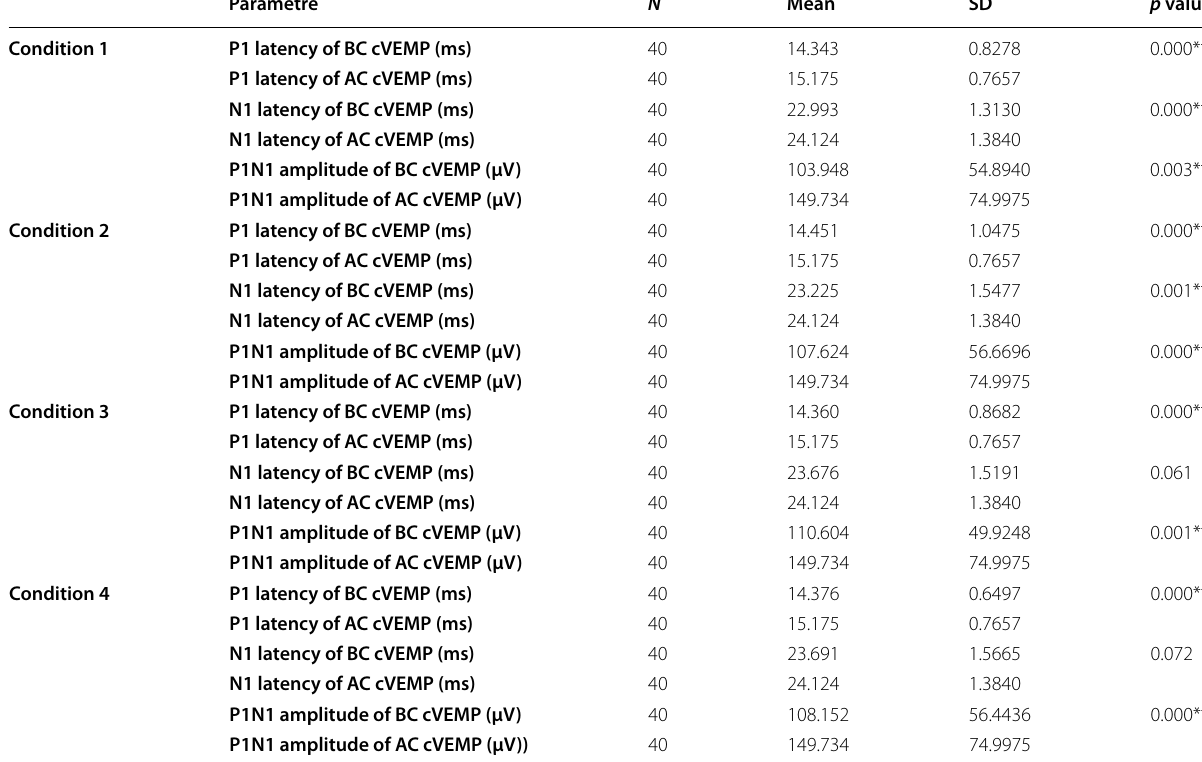
Table 4 Comparison of AC and BC cVEMP responses